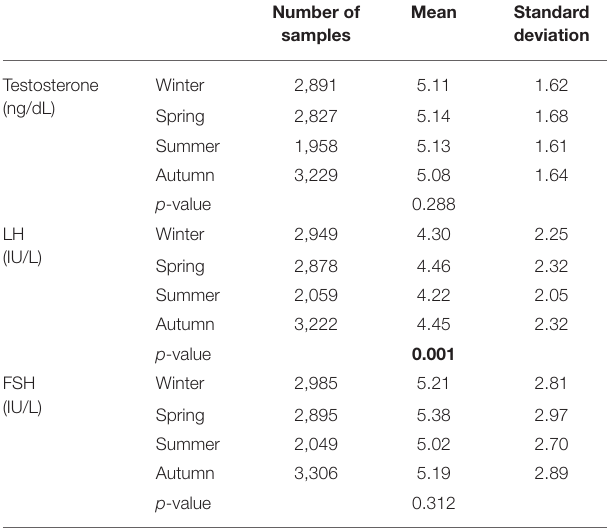
TABLE 2 | Hormone serum levels in the four seasons across the study years considering only hormones within the laboratory reference